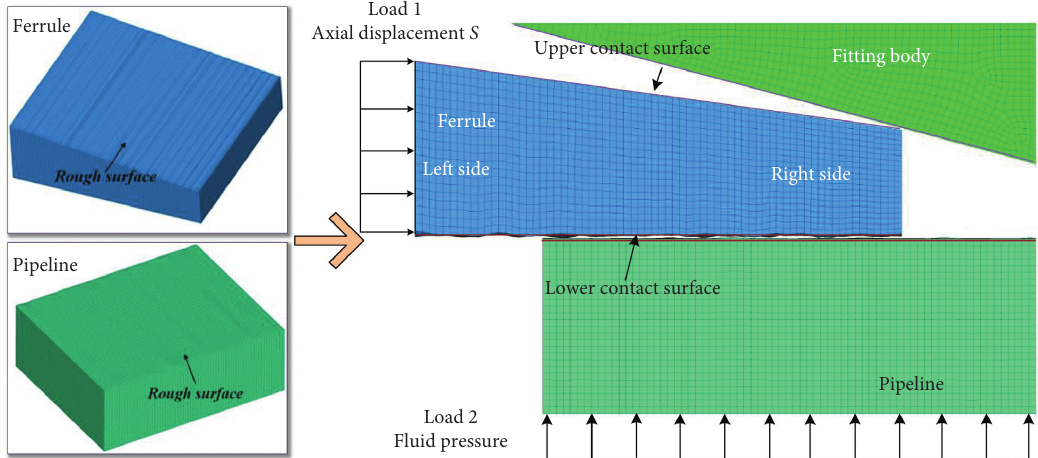
Figure 4: Multiscale model of pipeline fittings with the fluid